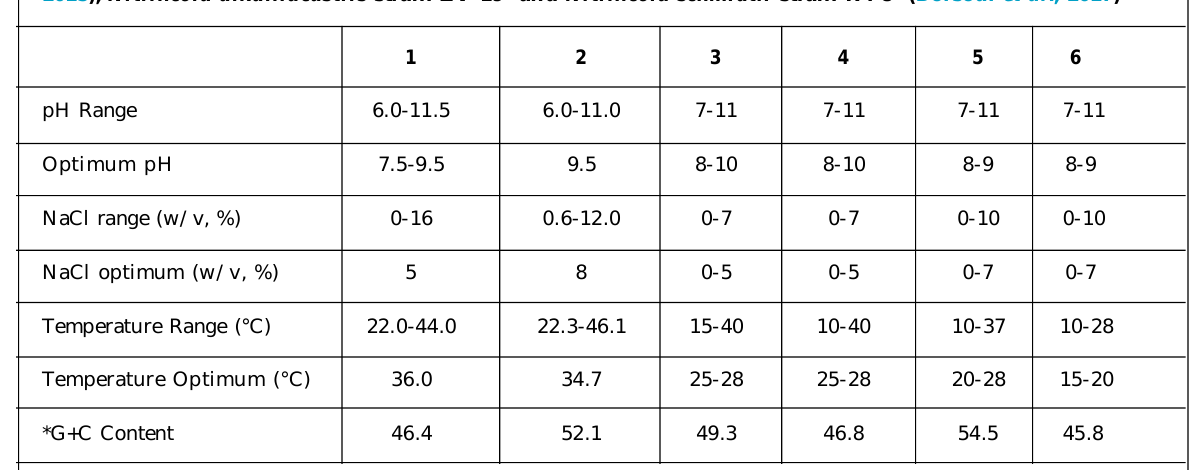
Table 1a: Physiological characteristics of the Isolates: 1, E-48 T ; 2, Nitrincola lacisaponensins (DSM 16316 T )